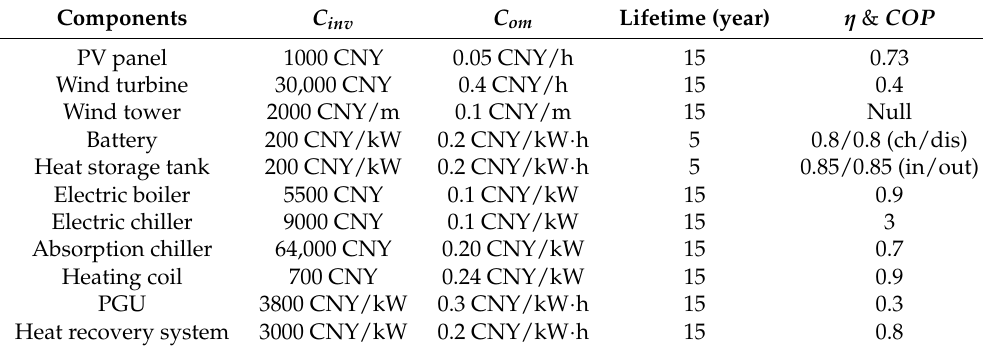
Table 1. The specifications for the RECCHP system components. COP : coefficient of performance.